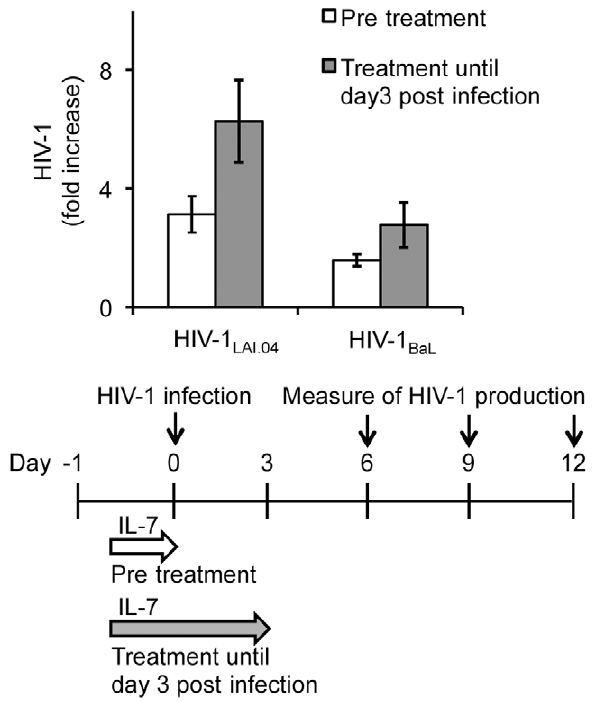
Figure 4. Exposure to IL-7 for a short time is sufficient to enhance HIV-1 production. Donor-matched lymphoid tissue blocks were treated with IL-7 overnight prior to infection with HIV-1 or until day 3 post infection, and subsequently cultured in the absence of IL-7. Presented are the average increases in the cumulative release of HIV-1 p24 gag in culture media of tissue blocks infected with HIV-1 LAI.04 ( n =4) or HIV-1 BaL ( n =5) and treated with IL-7 25 ng/mL compared with infected untreated donor-matched tissue blocks (means 6 s.e.m.).